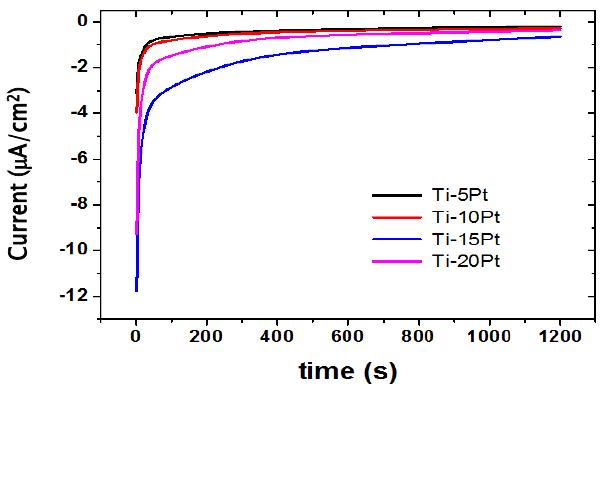
Figure 6. Mean values of galvanic currents versus time of couplings of cp-Ti/Ti-xPt